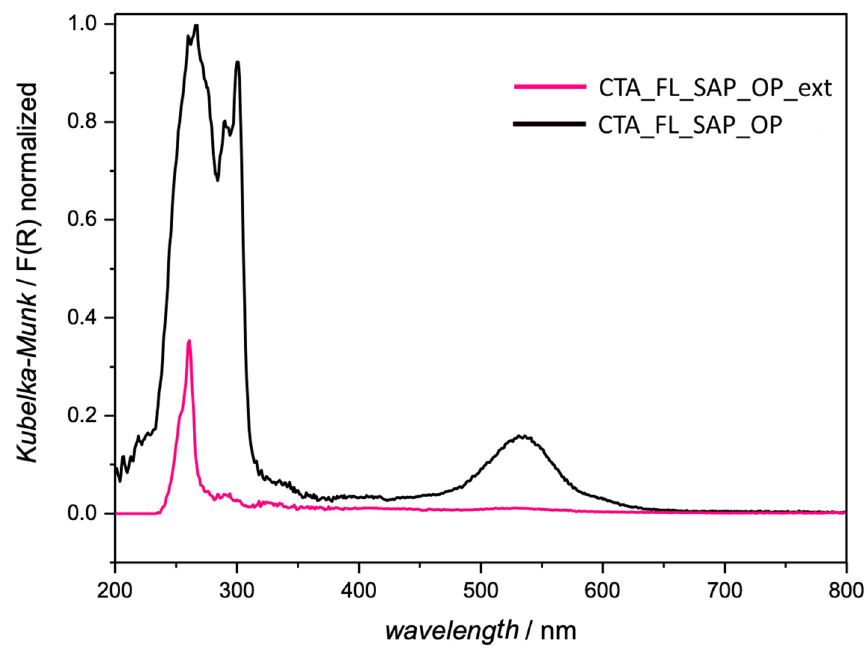
Figure 9. Normalized DR-UV/Vis spectra of CTA_FL_SAP_OP (black) and CTA_FL_SAP_OP_ext (pink).